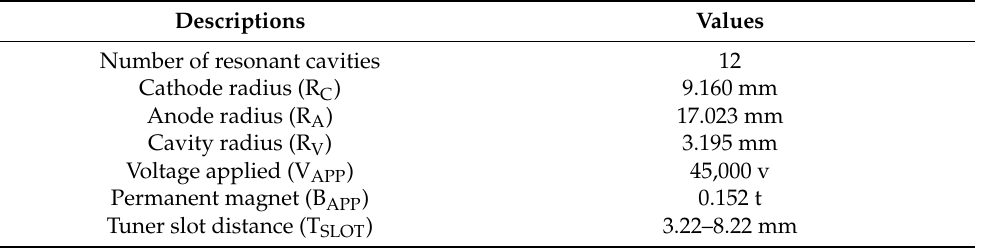
Table 1. Specification of the cavity